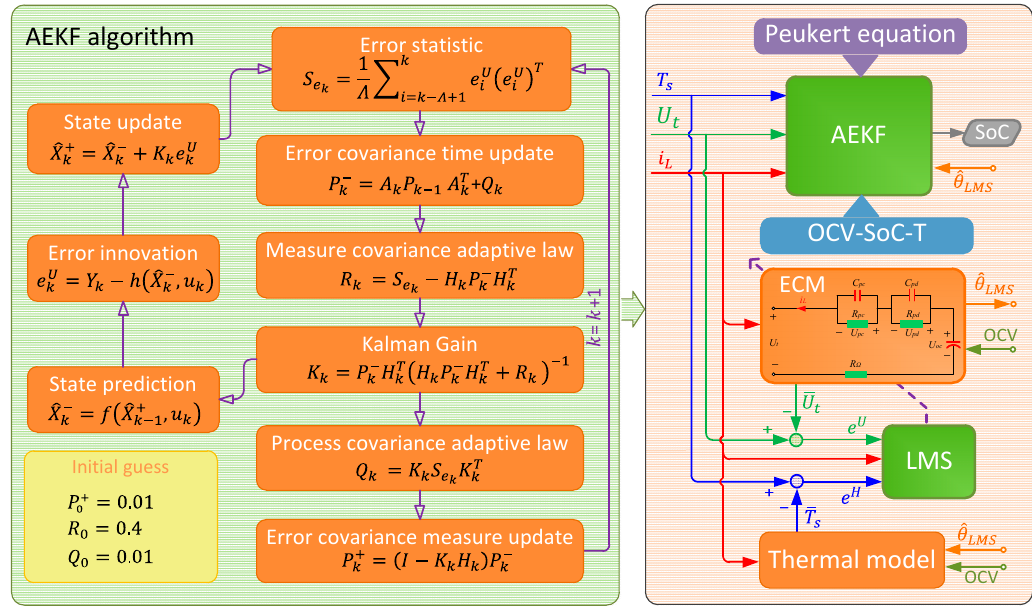
Figure 6. Details of the adaptive extended Kalman filter (AEKF) algorithm and the AEKF-based SoC estimation scheme, where Λ is the width of the moving average window, K is the Kalman gain, and P is the error covariance matrix. ECM = equivalent battery model; LMS = Least-Mean-Square. Figure 6 outlines the entire estimation framework. The ECM parameters ( θ LMS ) are tuned on-line with voltage and temperature prediction errors referring to Section 4.1. Enhanced by the